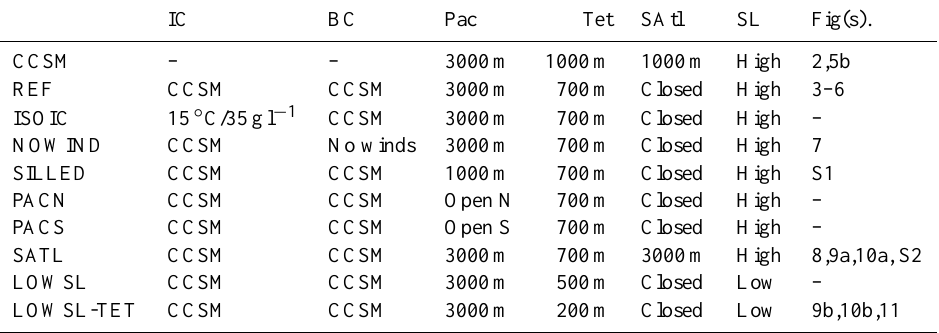
depth, the Tethys-Pacific flow band becomes smaller and retains its velocity, leading to high velocities in the whole northern gyre. At a depth of 500 m, velocities and elevated salinities decrease rapidly towards basin average values at 1500 m where the Tethys-Pacific flow band has completely disintegrated and salinities in the whole basin are homoge- neous at ∼ 35.6 g l − 1